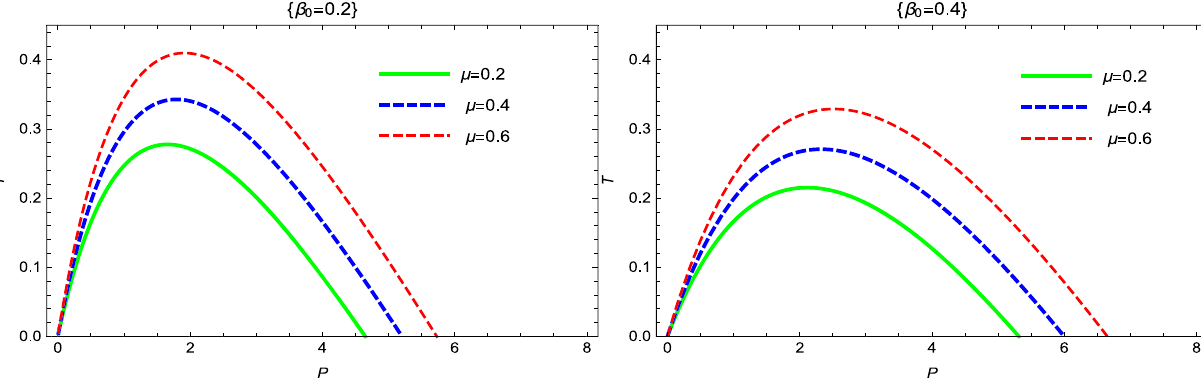
Fig. 11 Plot of isenthalpic curves with fixed value of β 0 = 0 . 2 and μ = ( 0 . 2 , 0 . 4 , 0 . 6 ) {left} and β 0 = 0 . 4 and μ = ( 0 . 2 , 0 . 4 , 0 . 6 )